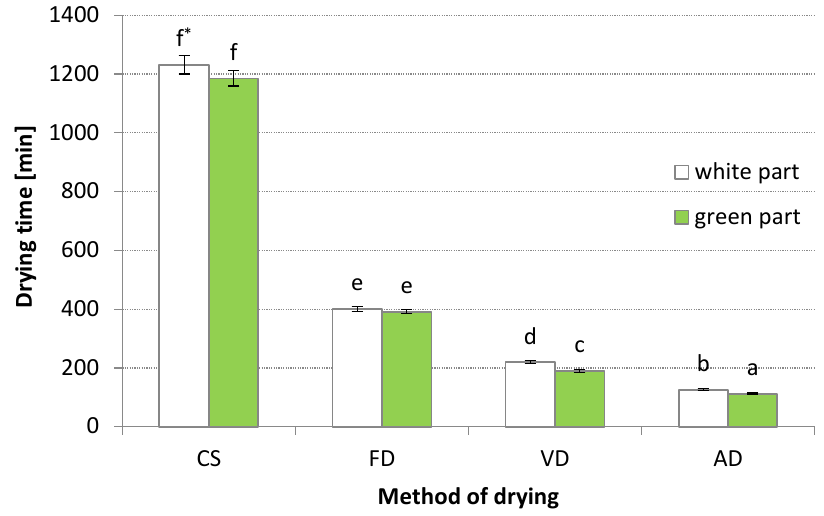
Figure 1. Drying time taken to achieve final moisture content of 10–11% using different methods in green and white shaft of leek: CS—control sample, FD—freeze-drying, VD—vacuum drying, AD—air drying; *The values designated by the different small letters significantly different (α = 0.05).